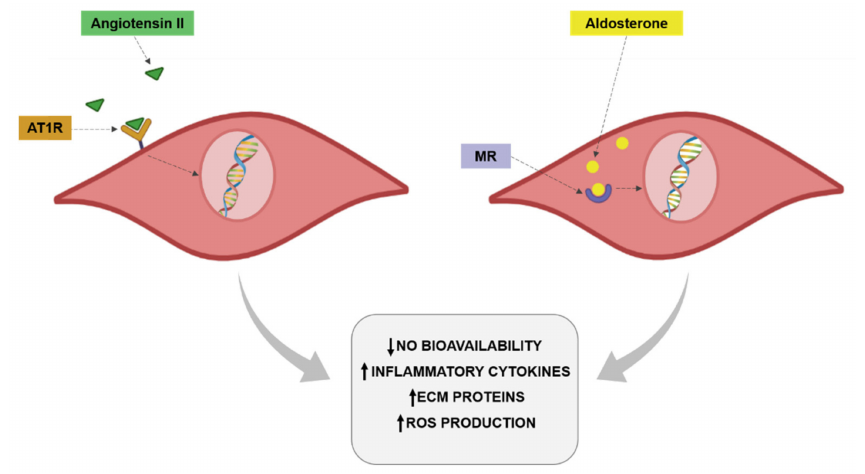
Figure 2. Angiotensin II and aldosterone effects on vascular